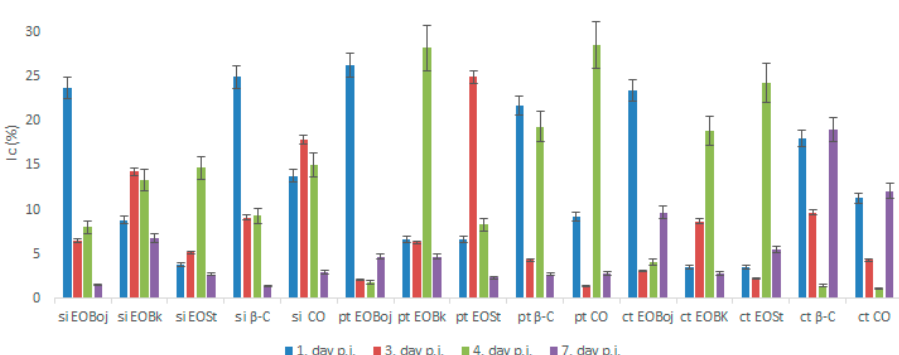
Figure 5. Inhibition of CMVsat (satellite associated Cucumber mosaic virus ) concentration (Ic) in Nicotiana megalosiphon plants following: Simultaneous inoculation (si) of virus inocula with essential oil (EO) of Micromeria croatica from the localities Bojinac (Boj), Ba č i ć kuk (Bk) and Stupa č inovo (St) or with β‐ caryophyllene ( β‐ C) and caryophyllene oxide (CO); treatment prior to inoculation (pt) with EO of M. croatica from the localities Boj, Bk and St or with β‐ C and CO; continuous treatment (ct) prior and after inoculation with EO of M. croatica from the localities Boj, Bk and St or with β‐ C and CO, all related to CMVsat concentration in control plants. All experimental groups consisted of about 50 plants. Leaves were harvested on days 1, 3, 4 and 7, post inoculation (p.i.). Values are expressed as the mean value ±